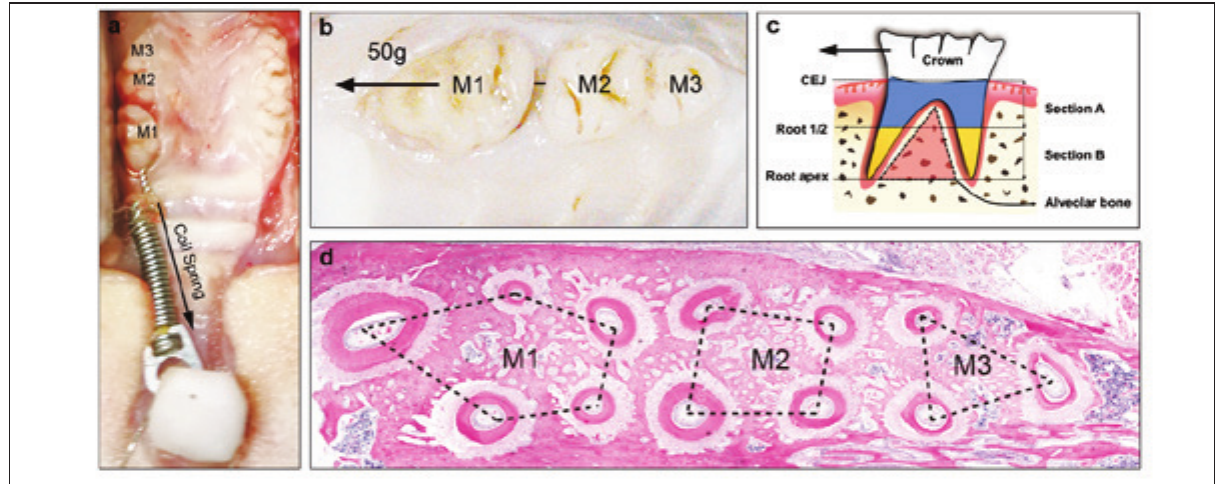
Figure 1. OTM models were constructed in 8-week-old SD rats with the spring apparatus, which could generate the force with a magnitude of 50 g. The left maxillary first molar was moved mesially and the right side was the control group (a-b). The maxillary alveolar bone below the cementoenamel junction (CEJ) was divided into two sections, the cervical 1/2 (section A) and apical 1/2 (section B) level (c). Three regions of interest (ROI) were analysed in both OTM and control group: the first molar (M1), the second molar (M2) and the third molar (M3)